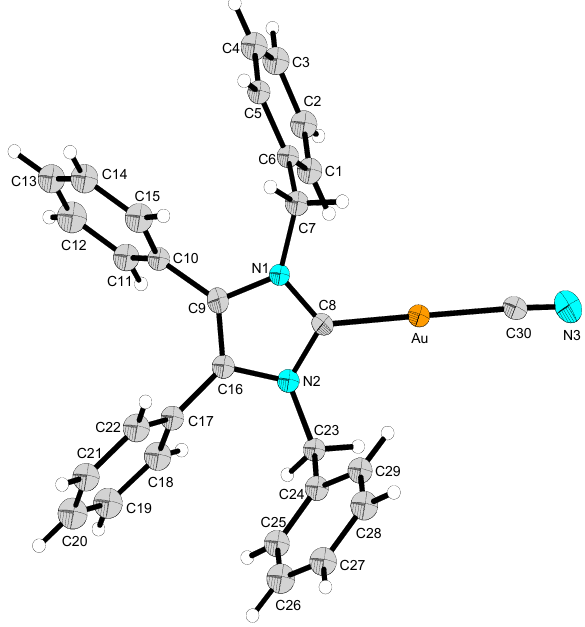
Figure 3. X-ray diffraction structure of NHC*-Au-CN ( 2 ); thermal ellipsoids are drawn on the 50% probability level.